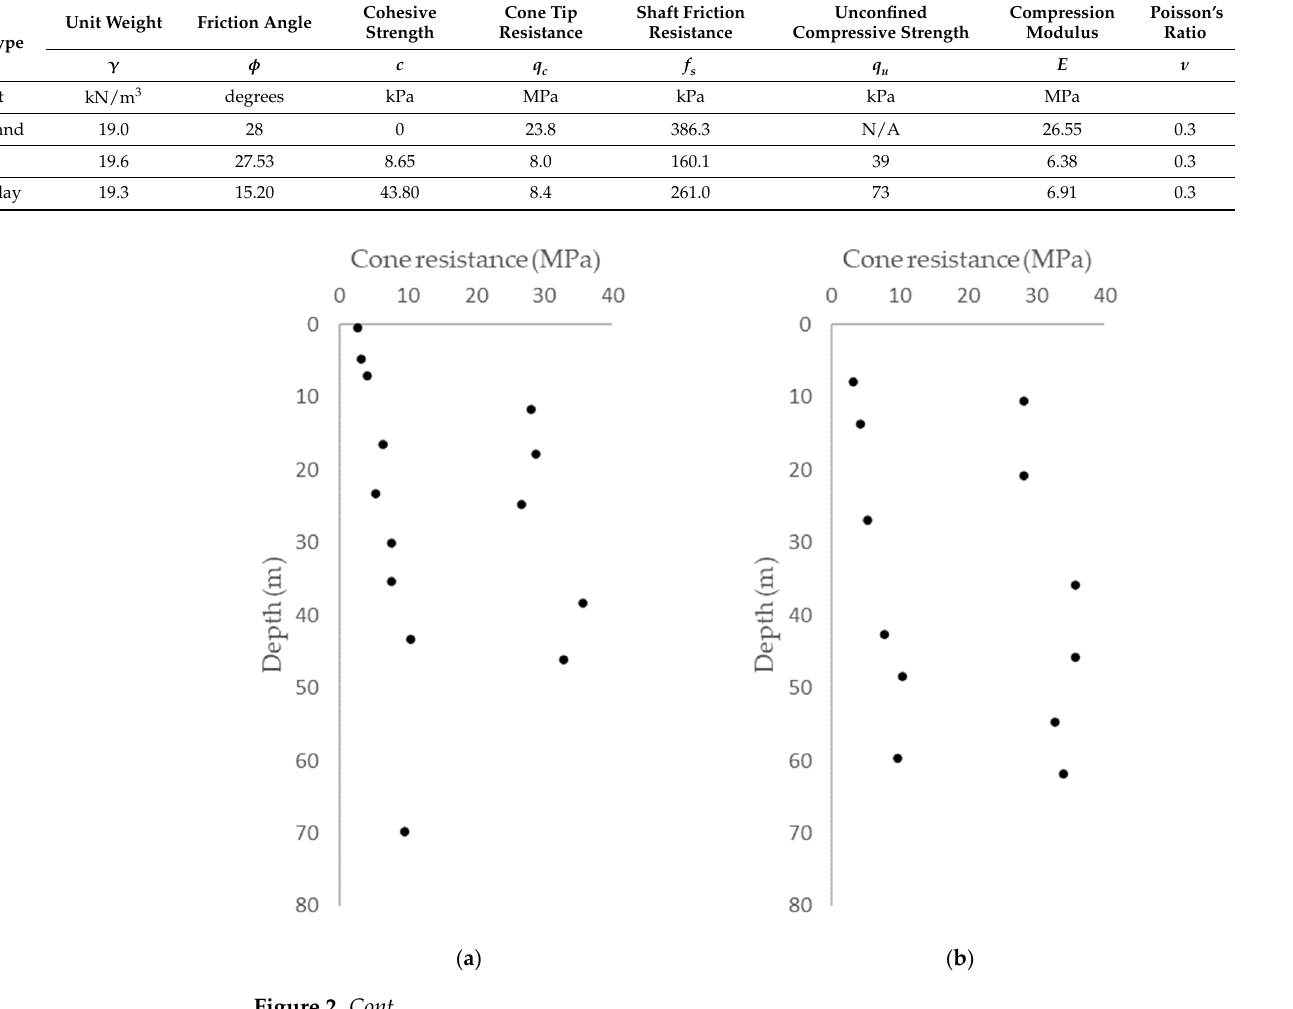
( d ) Figure 2. Cone penetration test results for ( a ) Test Pile 1, ( b ) Test Pile 2, ( c ) Test Pile 3 and ( d ) Test Pile 4.